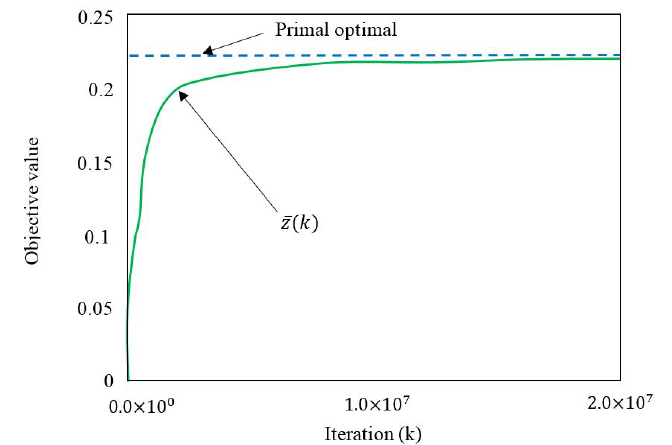
Figure 13. Convergence to the Optimal Solution in